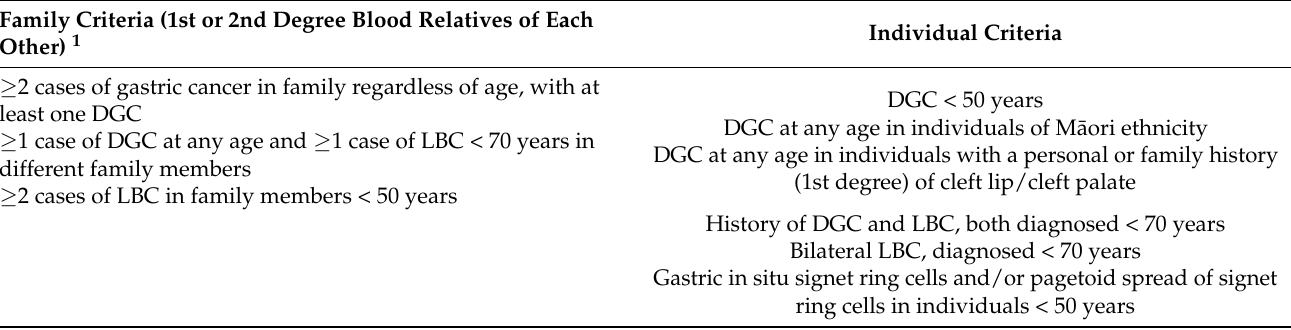
Table 2. IGCLC criteria for CDH1 testing (according to Blair et al., hereditary diffuse gastric cancer: updated clinical practice guidelines,